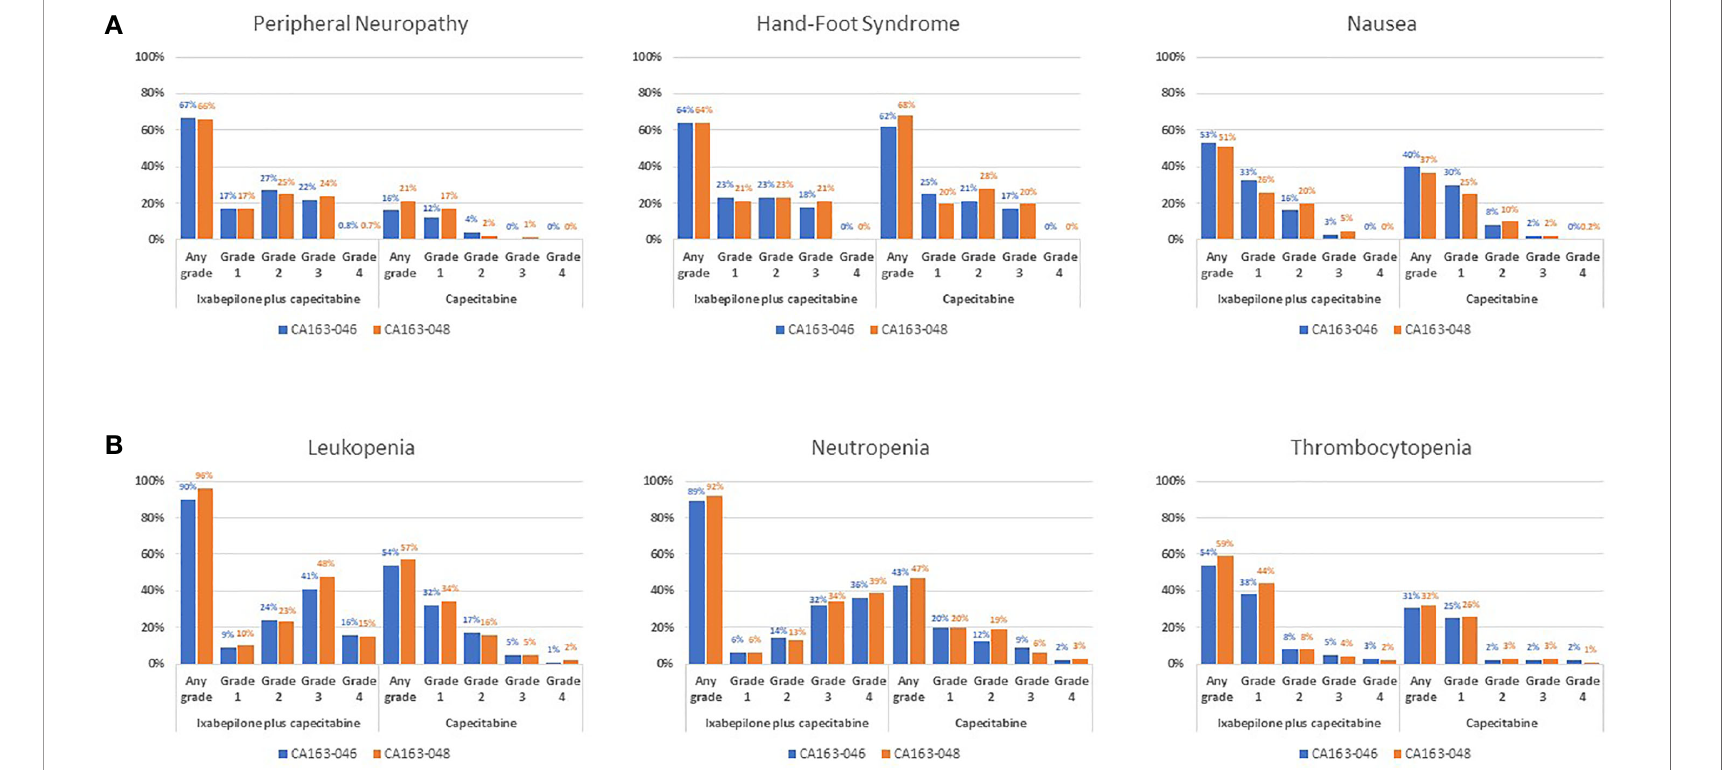
FIGURE 1 | TRAE Incidence Associated With I+C and C Treatment in Pooled Datasets From CA163-046 and CA163-048. Incidence of the most common (A) non-hematologic and (B) hematologic treatment- related adverse events in the CA163-046 and CA163-048 phase III trials. (20, 22) I, ixabepilone; I+C, ixabepilone plus capecitabine; TRAE, treatment-related adverse